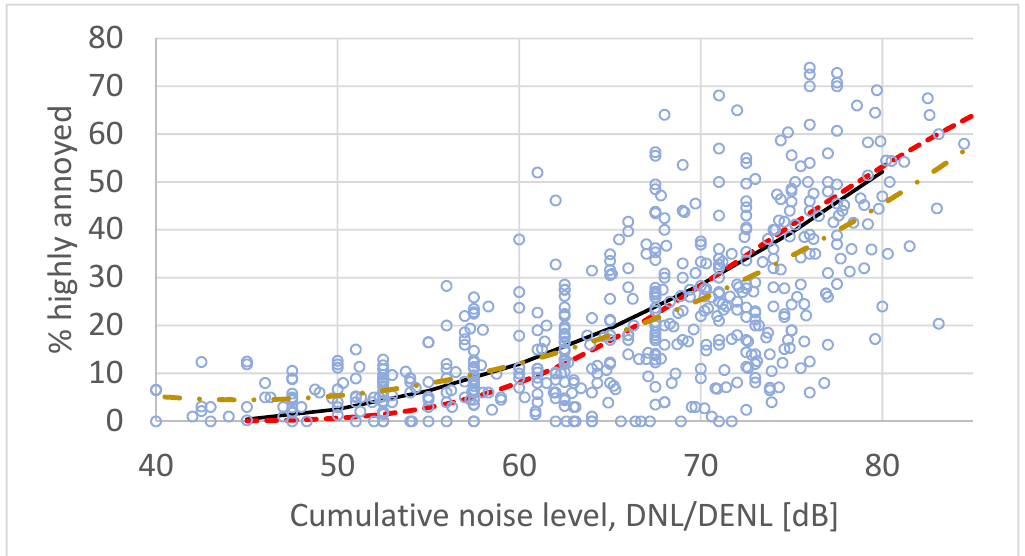
Figure 2. Set of paired exposure/annoyance observations from 61 surveys on road traffic noise (see Table 1). Solid line (black) is the ERF developed by Miedema and Vos. Standard second order polynomial regression yields the dash–dot ERF (yellow) while CTL analysis yields the dashed ERF (red).